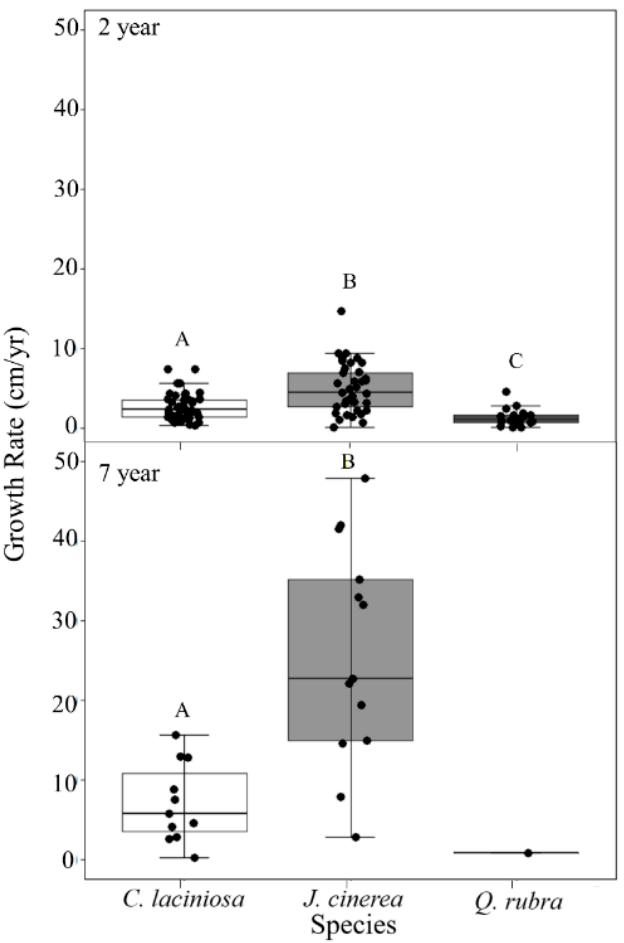
Figure 2. Height growth rate of three species of tree seedlings planted in a temperate forest understory in southwestern Ohio, USA, during a forest restoration experiment. The relative growth rates were calculated at two years and seven years by tree species. The middle bar in the box is the median, individual points represent seedlings, and letters indicate significant differences ( p < 0.05).